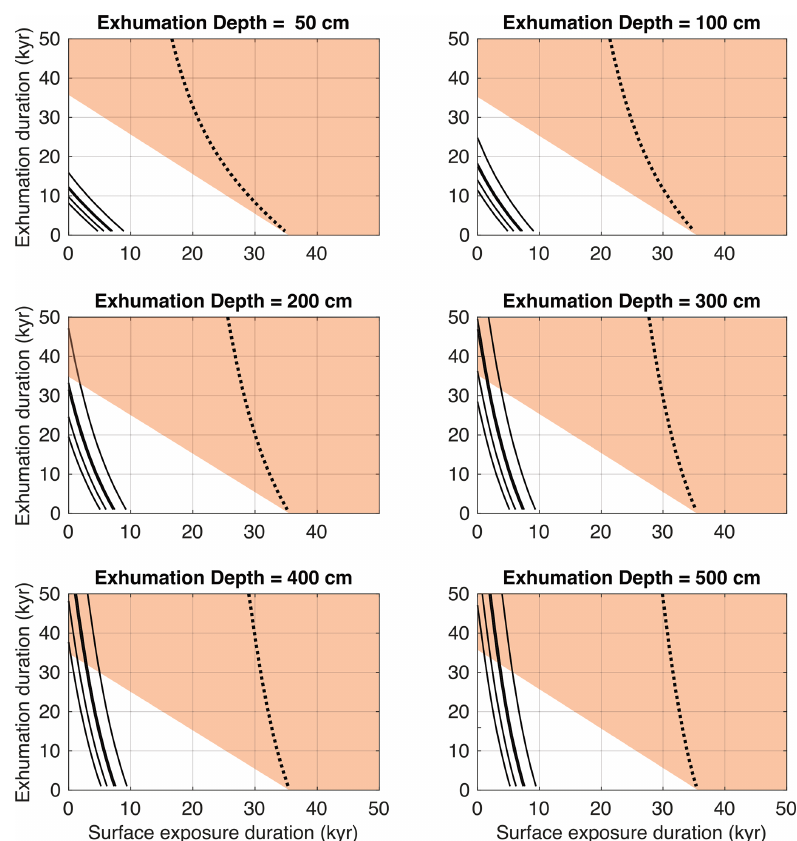
Figure 8. Contours of measured 14 C concentrations compatible with exhumation and exposure duration pairs for outer moraine samples. The dashed black line represents theoretical and measured saturation concentration (15-GH04) and effectively sets the minimum age of the outer moraines given the unlikelihood of 14 C inheritance. Orange shading represents the range of exhumation–exposure duration pairs compatible with saturated 14 C concentration. The intersection of lower concentration contours with orange shading represents compatible exhumation depths and